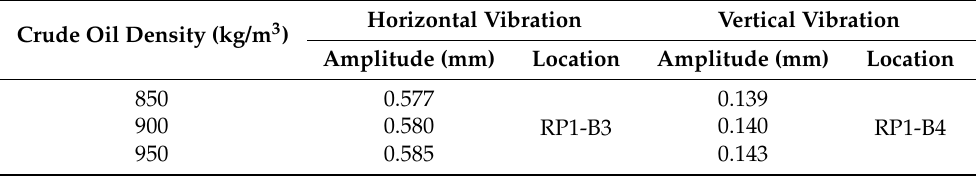
Table 11. Maximum amplitudes of RP1 outlet pipe at different crude oil densities.